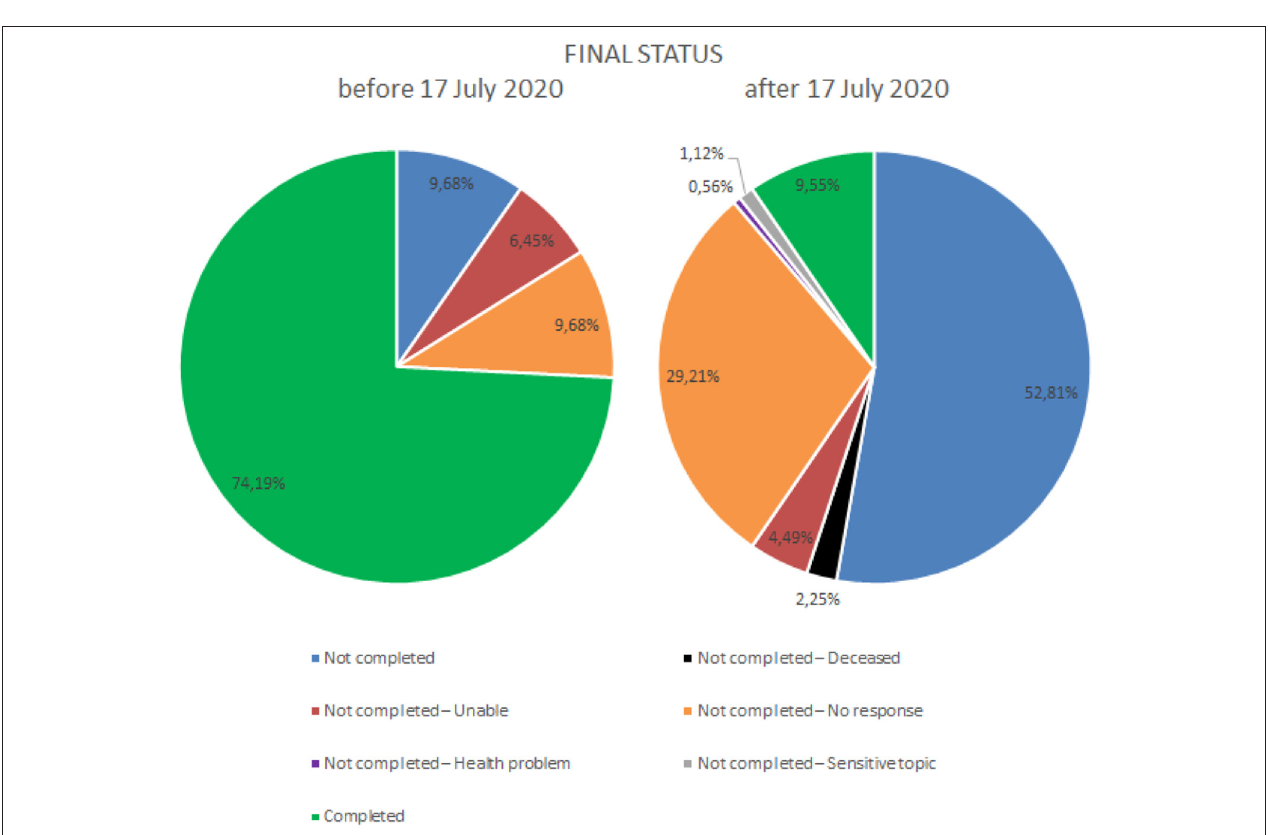
FIGURE 1 | Comparison chart of completion status before and after July 17,